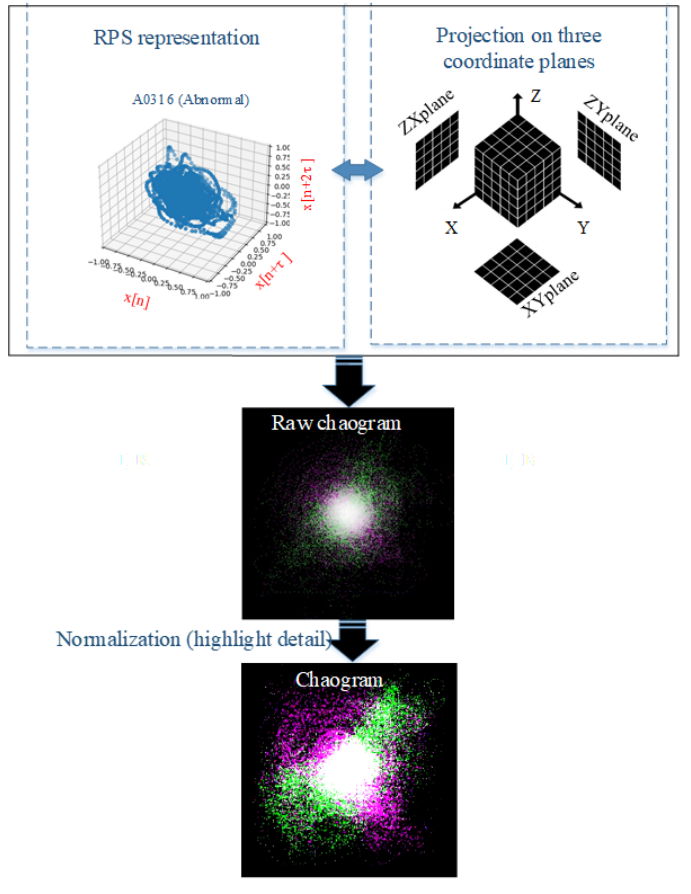
Figure 5. Extracting the chaogram image from the reconstructed phase space of a PCG